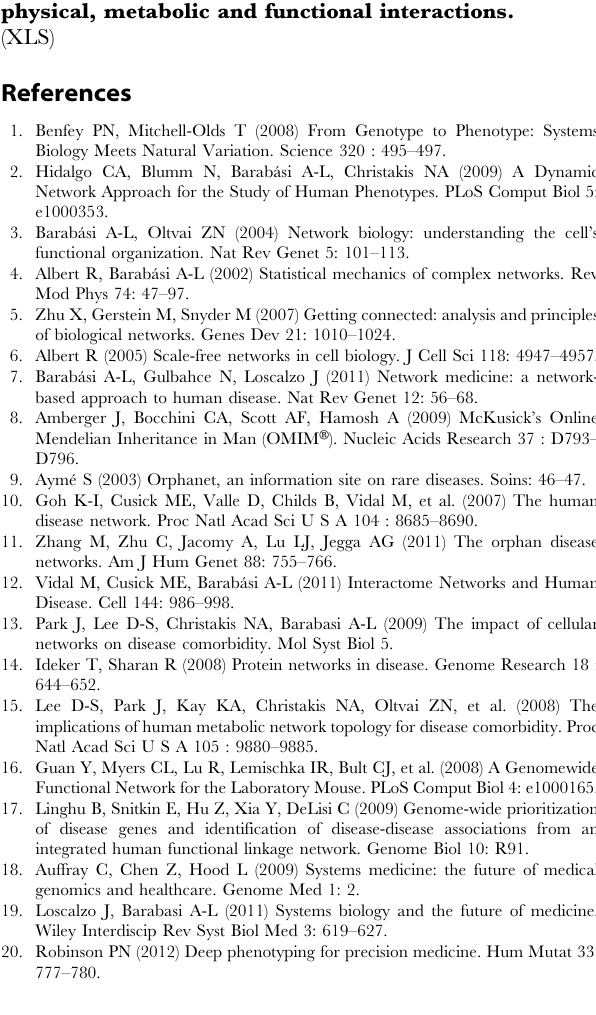
Table S6 Biomolecular interactome and PSGN sub- networks after nodal intersections. (XLS) Table S7 Pathophenotypic similarity gene network. Table S8 Spearman correlations between gene degrees in PSGN and HDGN/ODGN. Table S9 Spearman correlation between gene degrees in PSGN and biomolecular interactomes. Table S10 Network intersection between PSGN and PIN removing inferred gene-to-gene